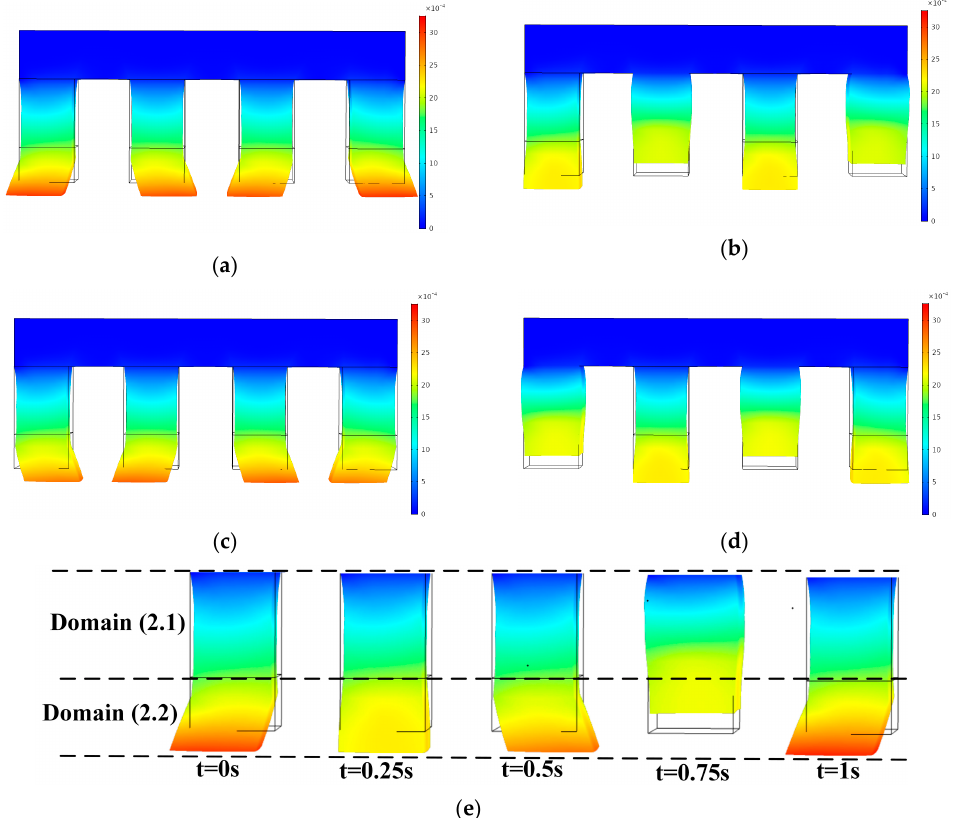
Figure 10. The gesture change of the actuation leg: ( a ) t = 0 s; ( b ) t = 0.25s; ( c ) t = 0.5 s; ( d ) t = 0.75 s; ( e ) one-leg gesture change in one second.